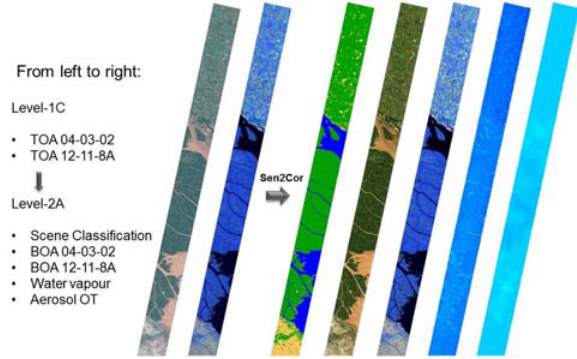
Figure 2. S-2 Level-2A product overview. © Telespazio The Scene Classification (SC) algorithm allows to detect clouds, snow and cloud shadows and to generate a